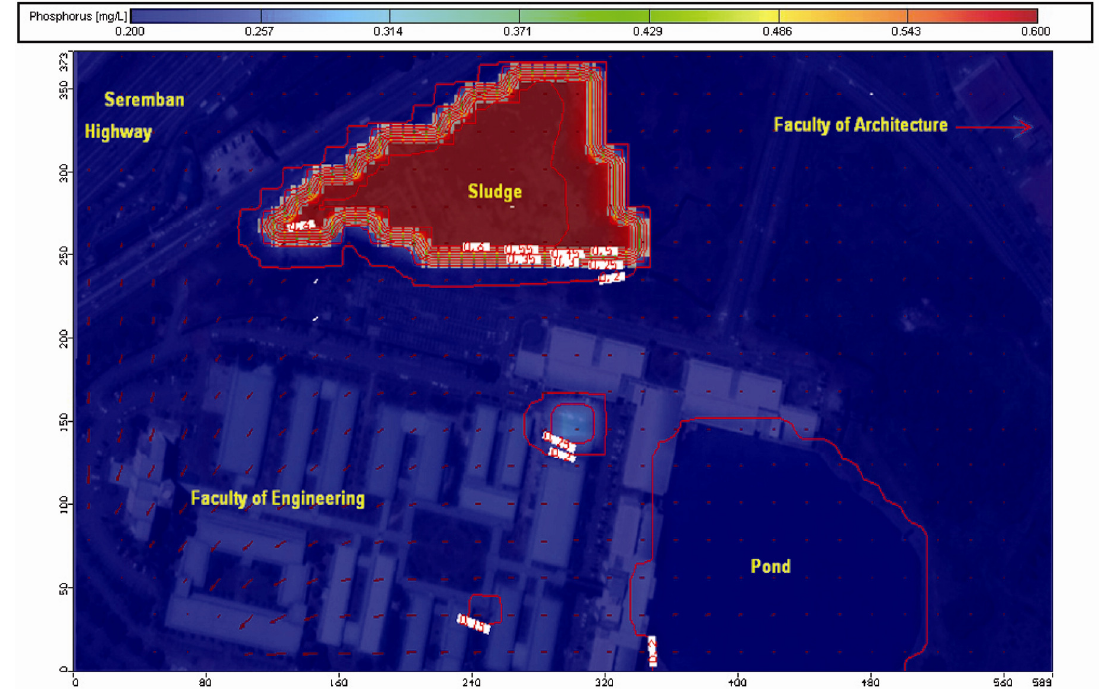
Fig. 3. Result of simulation of contamination migration in Layer No. 1 after 10 years